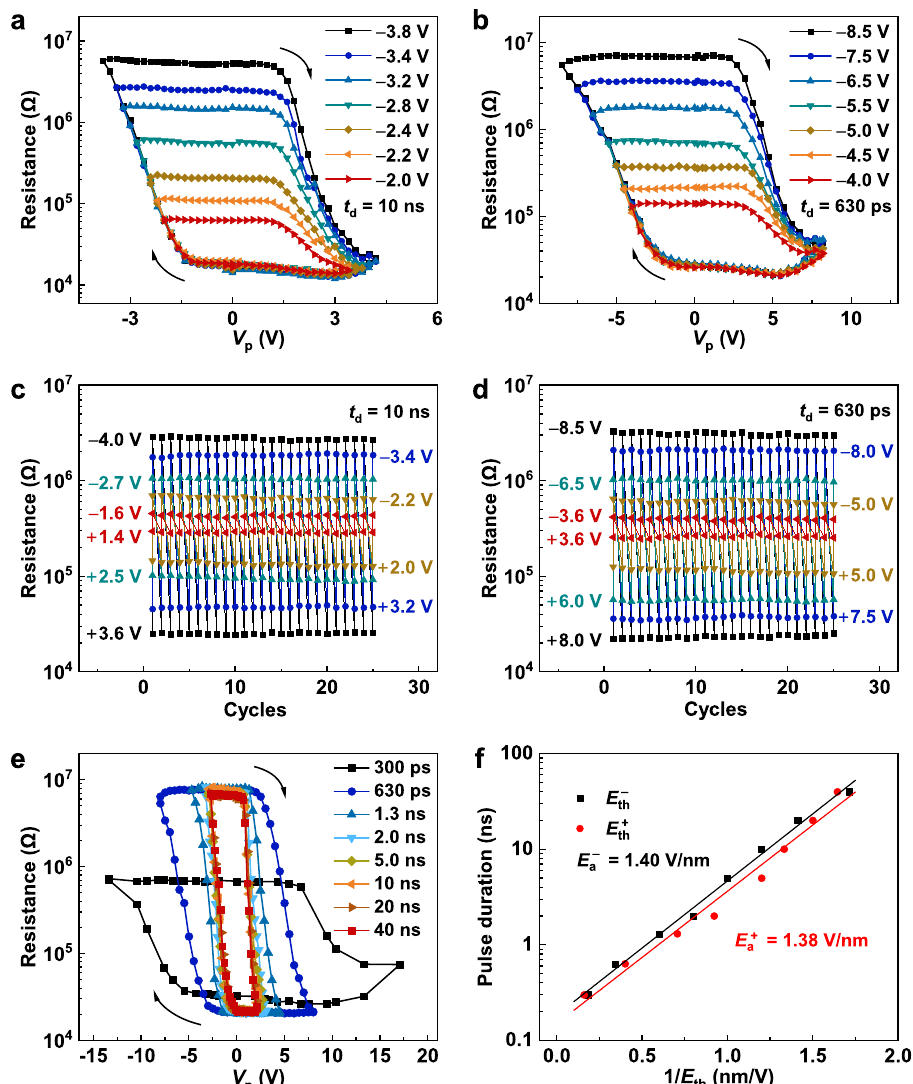
Fig. 4 Ultrafast memristive switching of the FTJ with a (111)-oriented PZT barrier. a , b Resistance measured at 0.05 V as a function of V p with a pulse duration of t d = 10 ns and t d = 630 ps. c, d Resistance switchings among different resistance states by applying different V p with t d = 10 ns and t d = 630 ps. e Resistances as a function of V p with various t d values from 300 ps to 40 ns. f Pulse duration versus inverse of threshold fi eld 1/| E th |. The solid lines are the results of fi tting by Mertz ’ s law. The arrows in a , b and e indicate the voltage sweeping